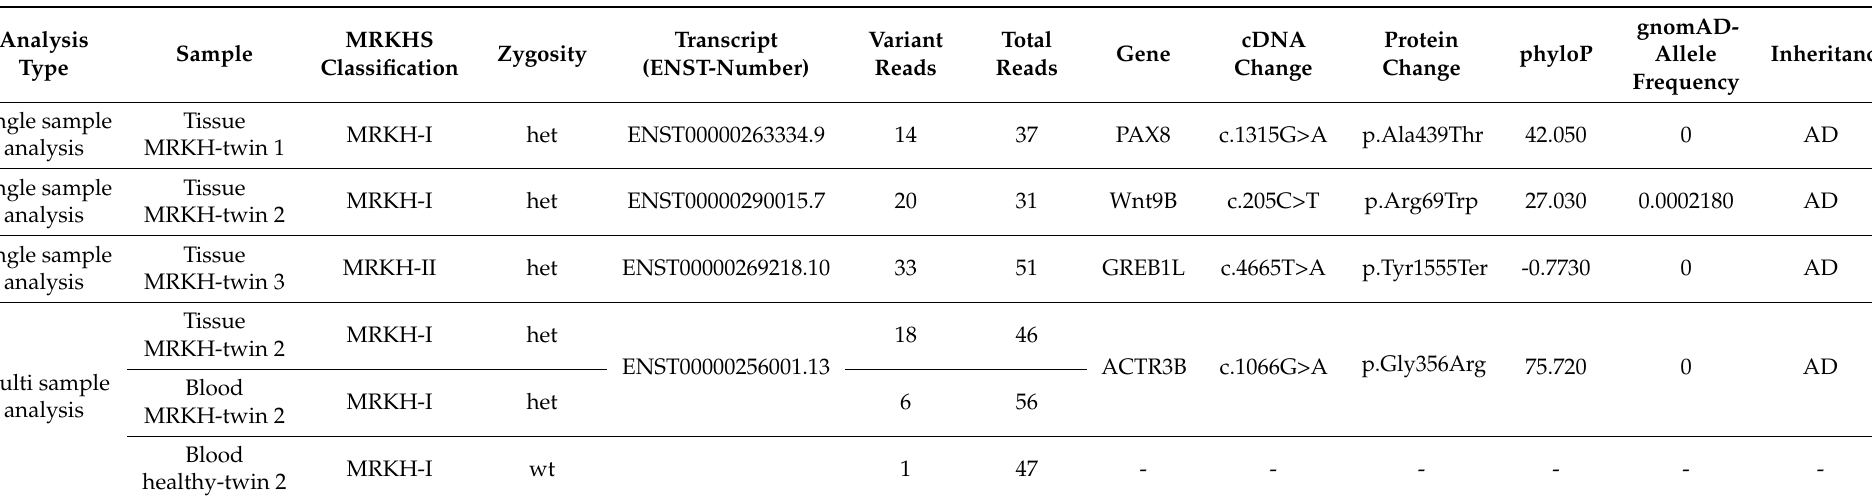
Table 2. Identified variants in SNV